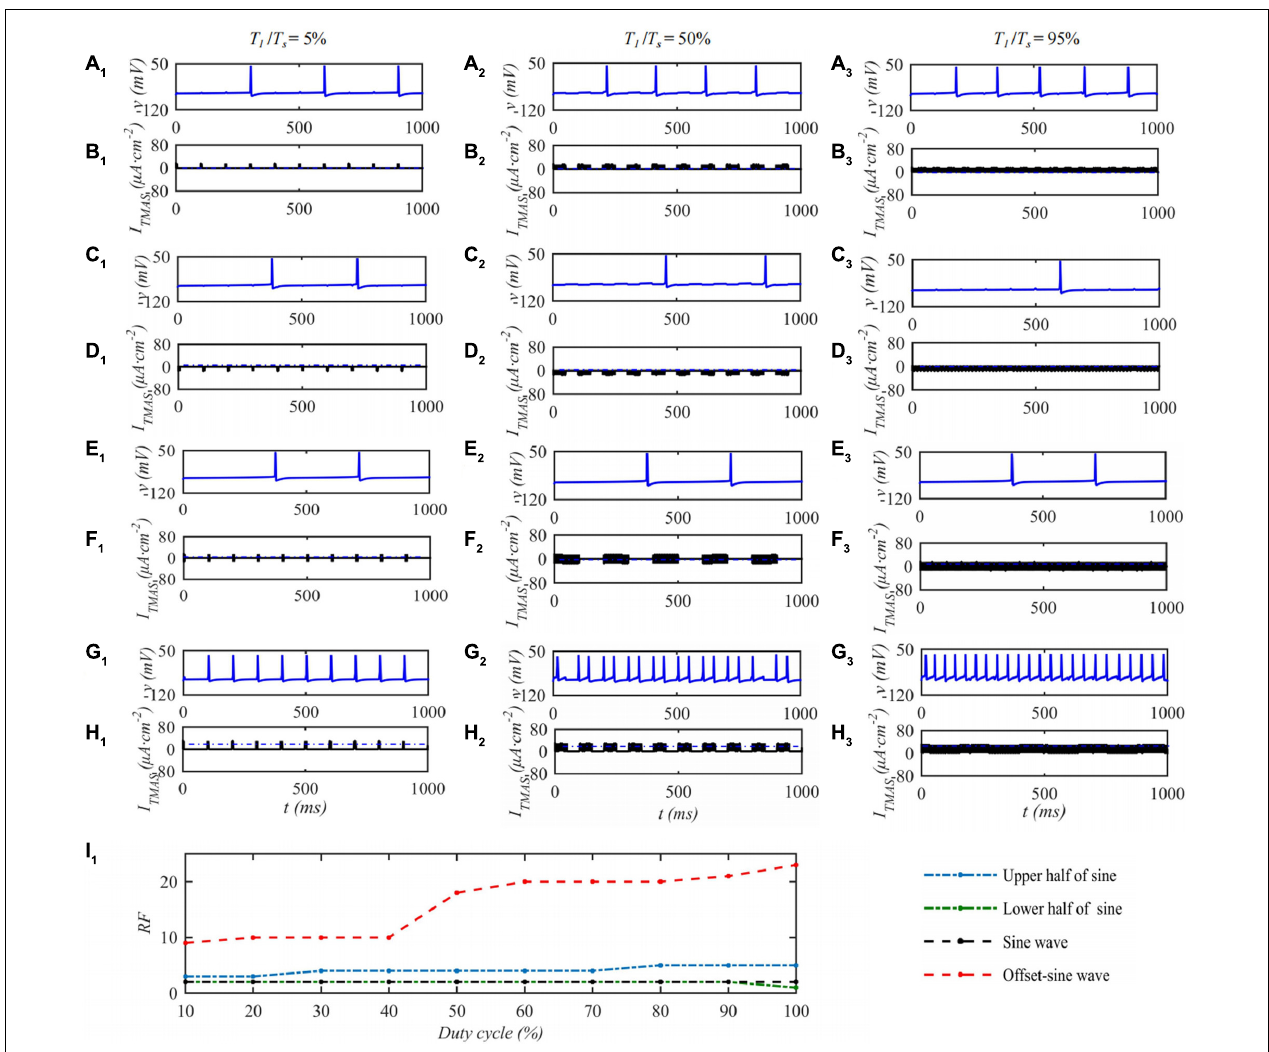
FIGURE 7 | The effect of TMAS duty cycle on the discharge of a single STN. Columns 1–3 Ultrasonic Duty Cycle, T 1 / T s = 5%, 50 and 95%, rows 1–4 are the upper, lower half sine wave, sine wave and offset sine wave stimulation, the blue and black curves are STN membrane potential and the TMAS-induced current, (I 1 ) is the curve of STN neuron firing rate versus TMAS duty cycle ( f = 0.5 MHz, f s = 10 Hz, I 0 = 0.1 W · cm - 2 , B = 0.3